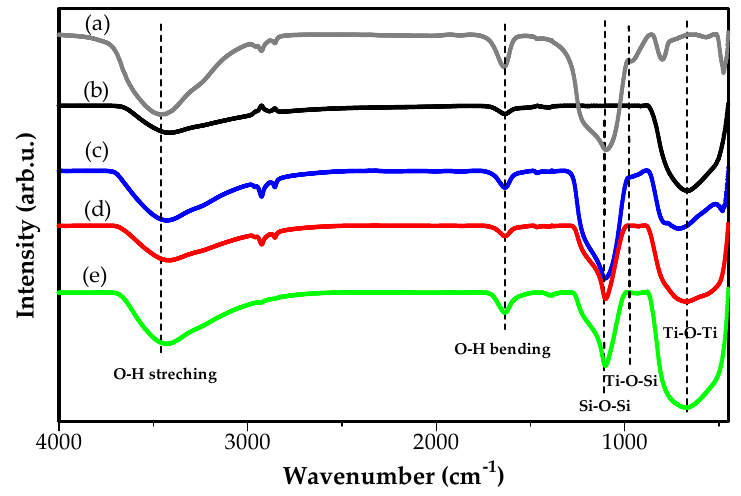
Figure 2. Fourier transform infrared (FTIR) spectrum of ( a ) SiO 2 ; ( b ) TiO 2 P25; ( c ) TiO 2 / SiO 2 (1:1) composite; ( d ) TiO 2 / SiO 2 (3:1) composite and; ( e ) TiO 2 / SiO 2 (7:1) composite.